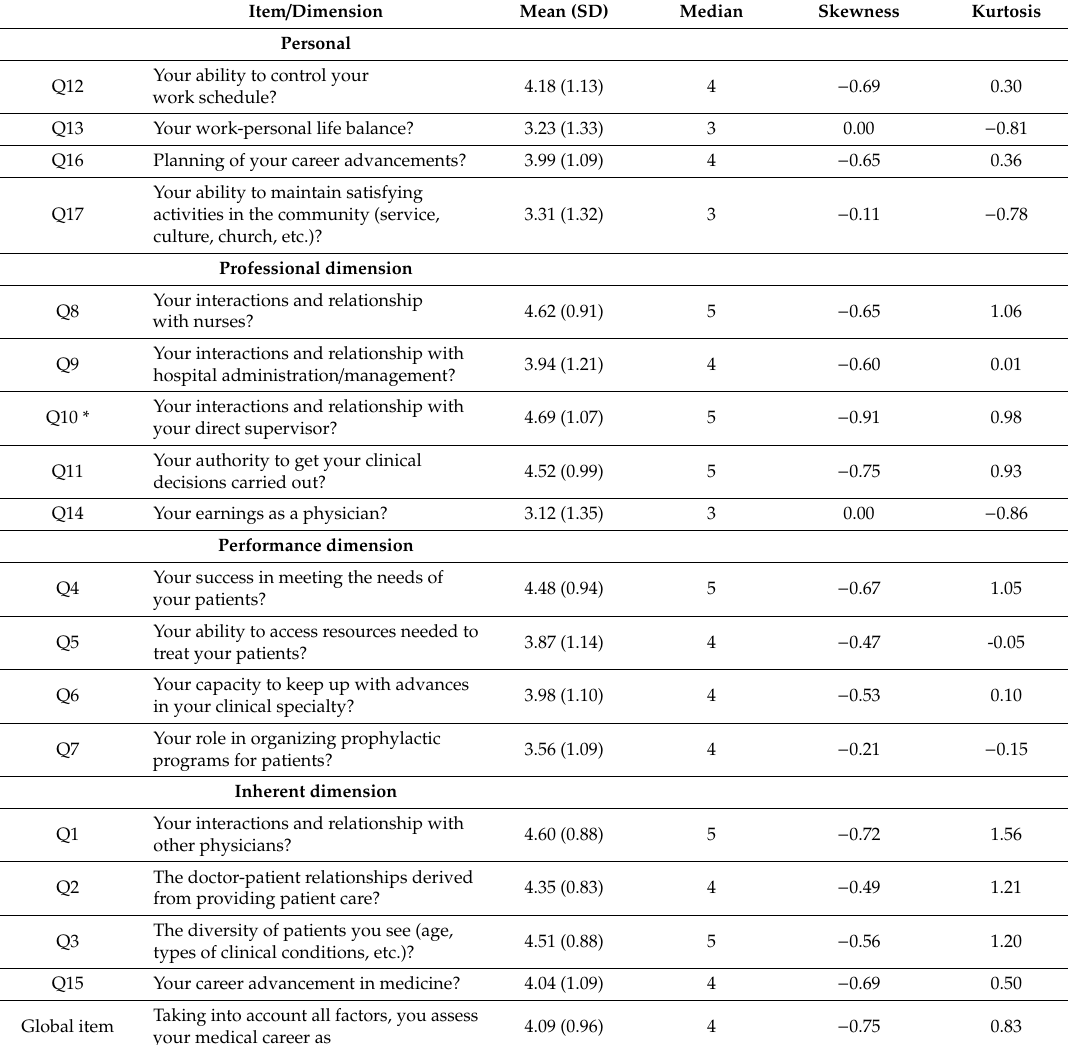
Table 1. Descriptive statistics items of the 4CornerSAT to measure the career satisfaction of physicians ( n = 1003); the questionnaire items are organized by